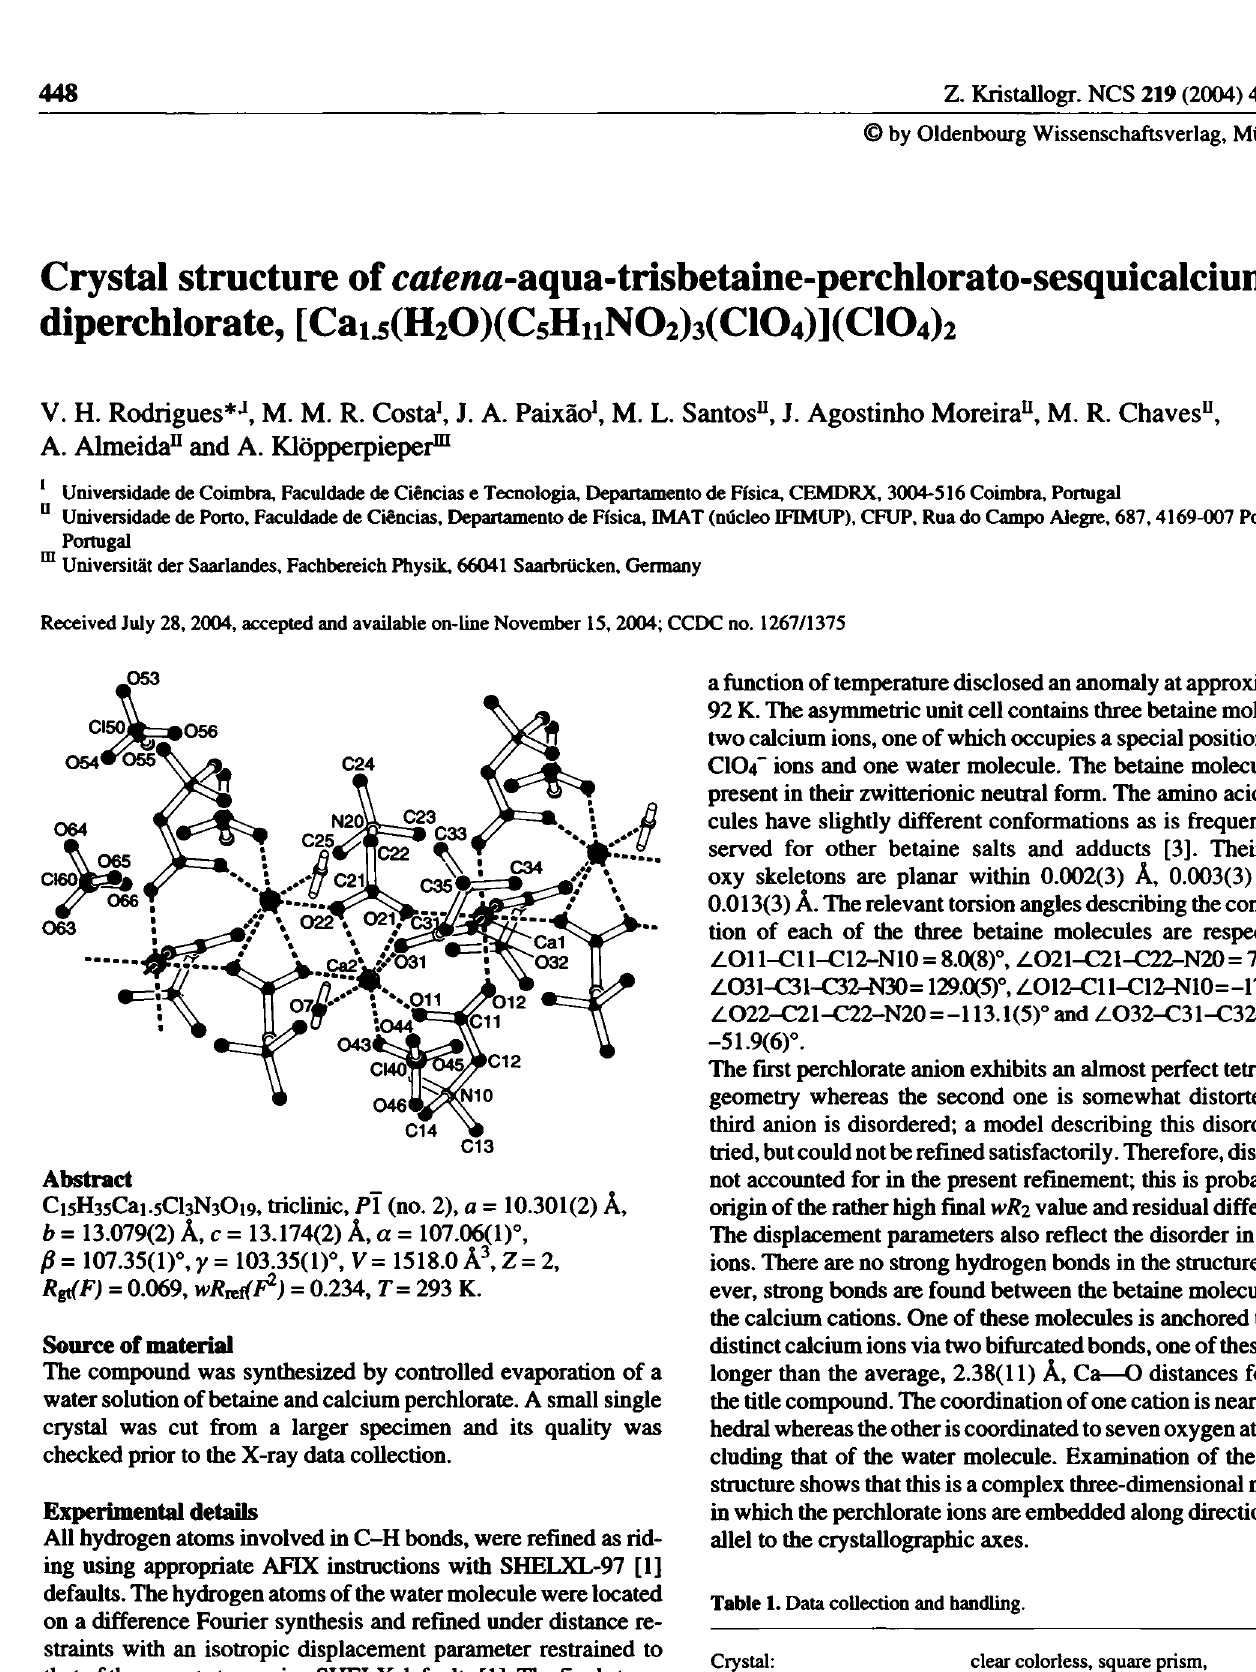
Table 1. Data collection and